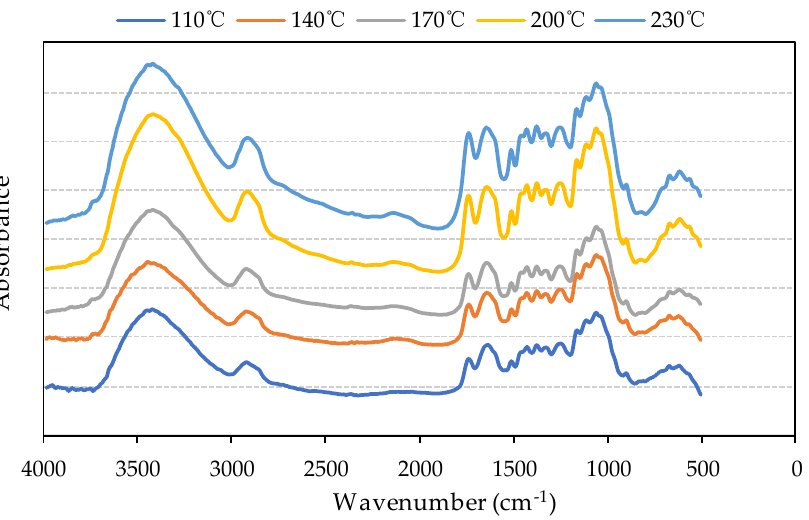
Figure 5. FTIR spectra of the samples at different heating temperature.